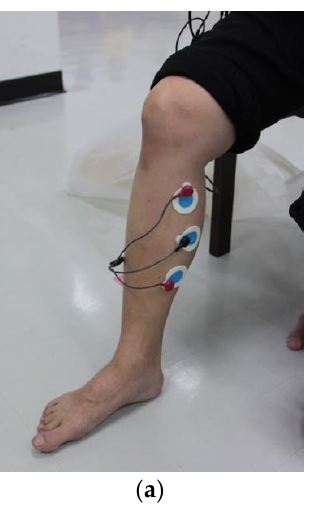
Figure 4. ( a ) dEMG from the medial gastrocnemius; ( b ) dEMG from the medial gastrocnemius while wearing an AAFO; and ( c ) dEMG from the medial gastrocnemius while wearing a PAFO. Abbreviations: AAFO, anterior ankle foot orthosis; PAFO, posterior ankle foot orthosis; dEMG, dynamic electromyography.